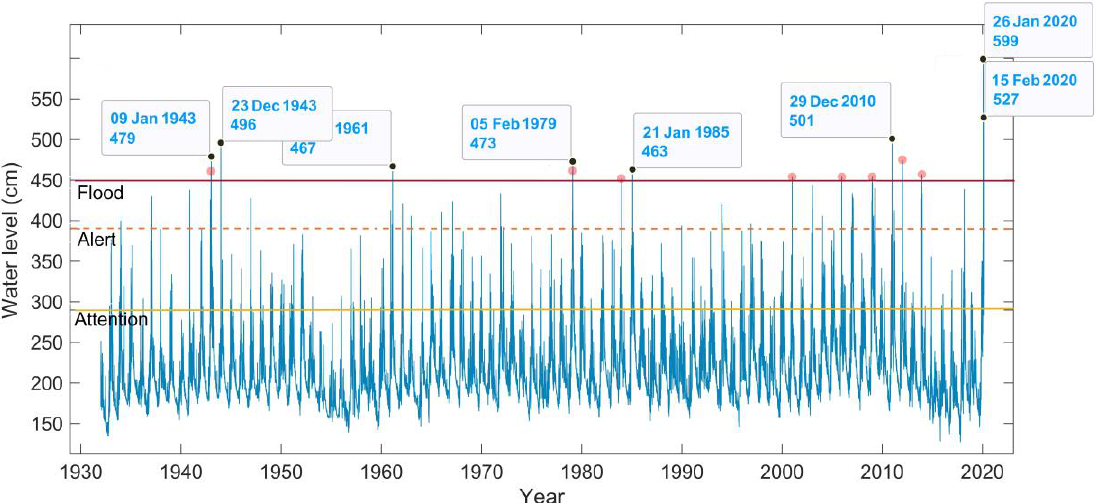
Figure 3. Temporal evolution of the Muriaé River water levels at the urbanized area of the municipality of Itaperuna, where the red line means the flood level (450 cm), the dashed orange line displays the alert level (390 cm), and the yellow line presents the attention level (290 cm) [42].